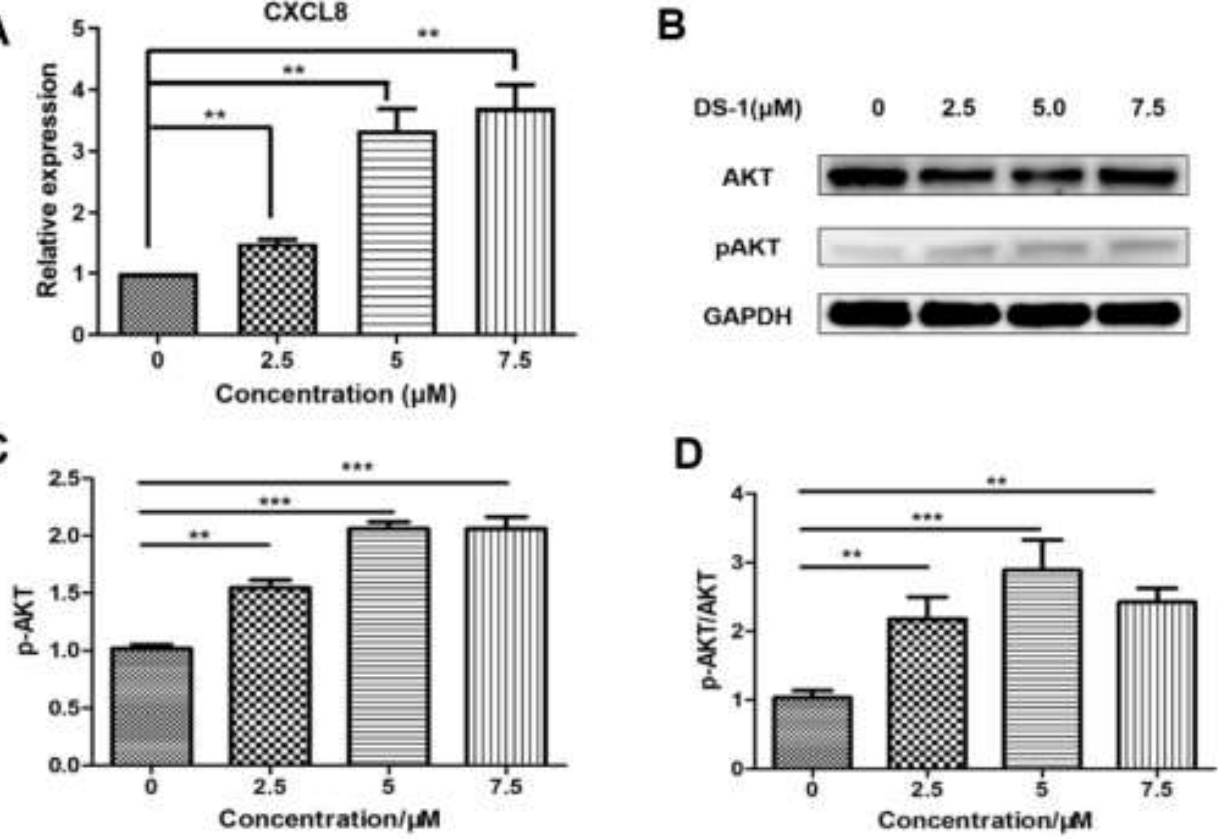
Figure 9. DS − 1 induced upregulation of AKT phosphorylation in U − 2 OS cells. ( A ) U − 2OS cells were treated with DS − 1 at 0, 2.5, 5, and 7.5 µM for 24 h, and the change in CXCL8 mRNA was analyzed by RT-PCR and is presented in the histogram. ( B ) U − 2 OS cells were treated with DS − 1 at 0, 2.5, 5, and 7.5 µM for 24 h, and proteins AKT and p-AKT were analyzed by Western blot. ( C ) The result of the Western blot was calculated by Image J and shown in the histogram. ( D ) The p-AKT/AKT value is shown in the histogram. Values are the average of three independent experiments, ** p < 0.01, *** p < 0.005.